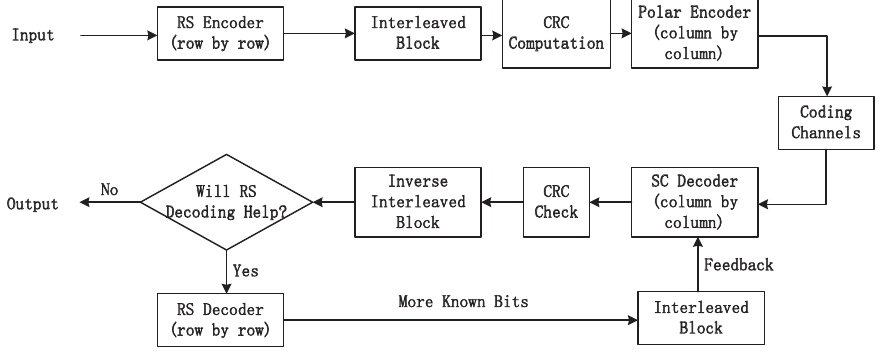
Figure 2. System diagram of the proposed UEP-RS-polar